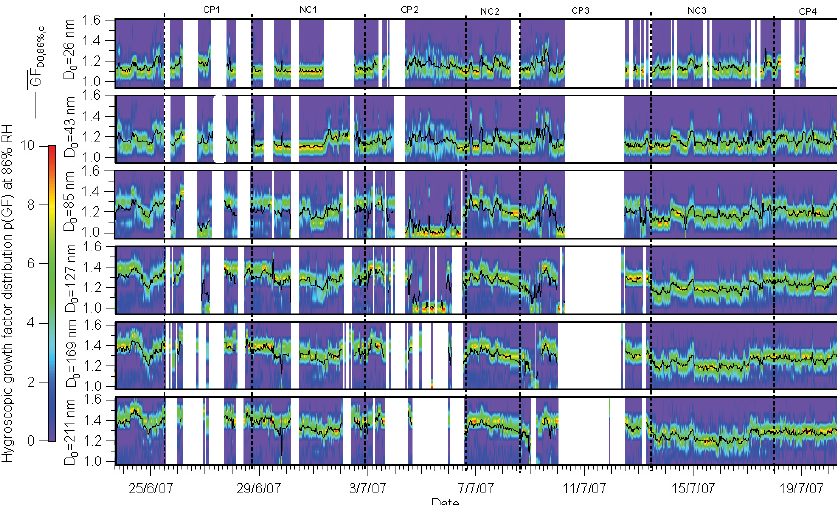
Fig. 1. Measured HTDMA hygroscopic growth factor probability distribution, p (GF), as a function of time. The HTDMA growth factor distribution is typically well represented by the mean growth factor, GF D seen with an increase of size (see Fig. S6 in the